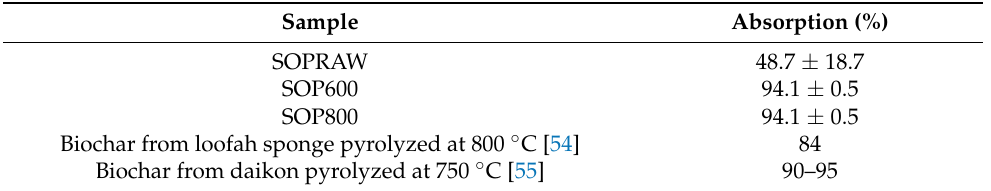
Table 4. Solar absorption percentages in the UV − VIS − NIR interval of SOPRAW and